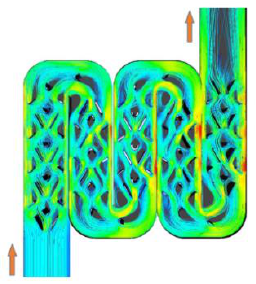
Fig. 1. Photocatalytic reactor concept [11]